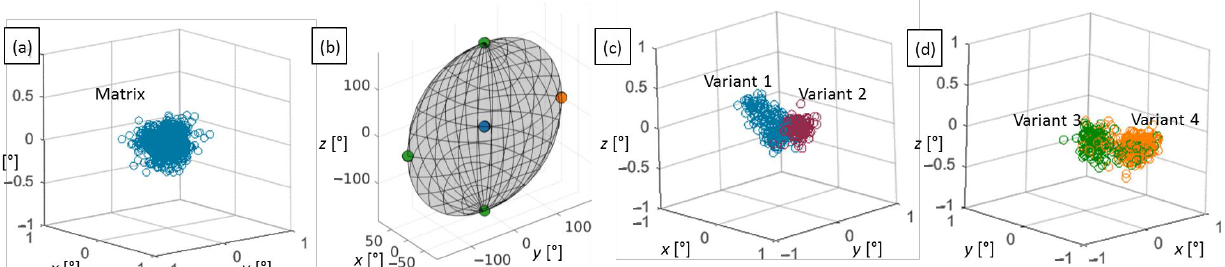
Figure 5. EBSD based orientation analysis from the η / η′ powder particle shown in Figure 2c using the axis-angle orientation space [42], where the distance from the origin corresponds to the misorientation angle, and the direction corresponds to the misorientation axis of the orientation with respect to the reference orientation. Reference orientation is the average orientation of the orientation points shown in cases ( a , c , d ), whereas it is the average matrix orientation in ( b ). The η matrix ( a ) and the η′ variants ( b ) are shown schematically, where the four points at the boundaries of the fundamental zone actually correspond to one double orientation cluster as visible in ( d ). The small orientation differences between pairs of the four domain variants are highlighted in ( c , d ). These pairs in ( c , d ) differ from each other by a rotation of 180°, e.g., around 𝐞̂ 3C (Figure 1) visible in ( b ).